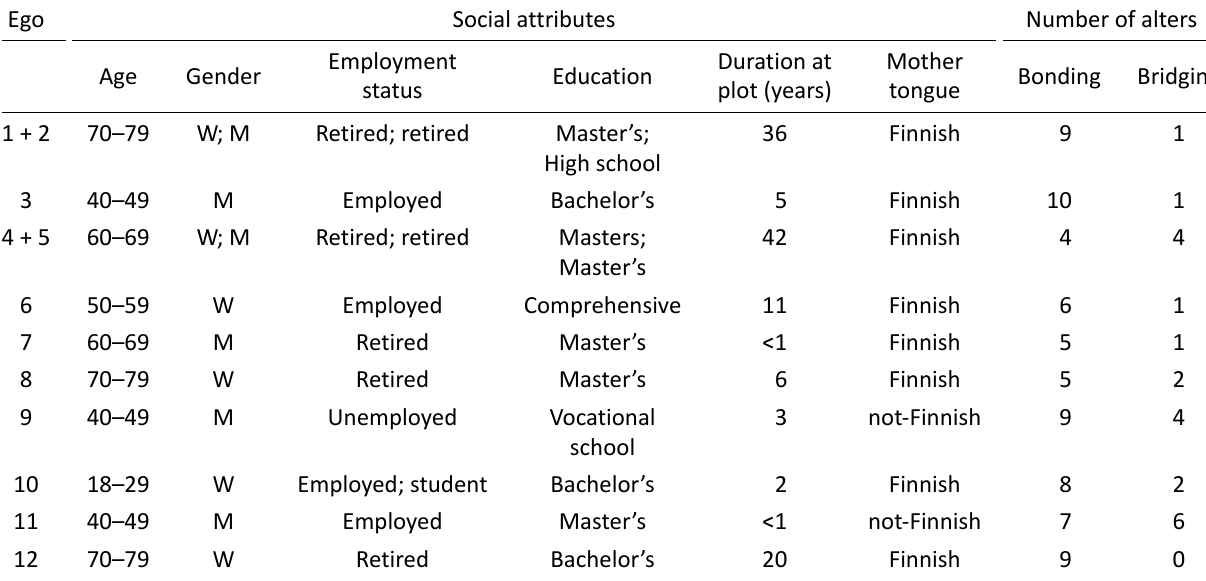
Table 1. Social attributes of the research